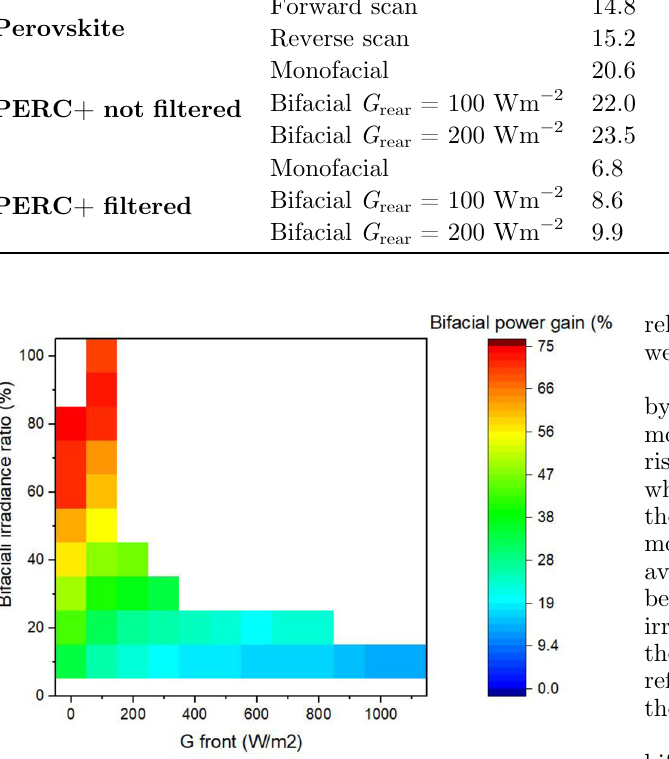
Fig. 6. Dependency of the bifacial gain to the bifacial and front irradiance. The roof on which the devices were installed has an albedo of ∼ 10%. The irradiance at the rear of the tandem devices is never less than 5% of the irradiance at the front of the devices. The high values of bifacial irradiance ratio and irradiance can be explained by local effects of the apparent yearly solar movement. Note that the photovoltaic data is not temperature corrected, and data with an incidence less than 5 times is